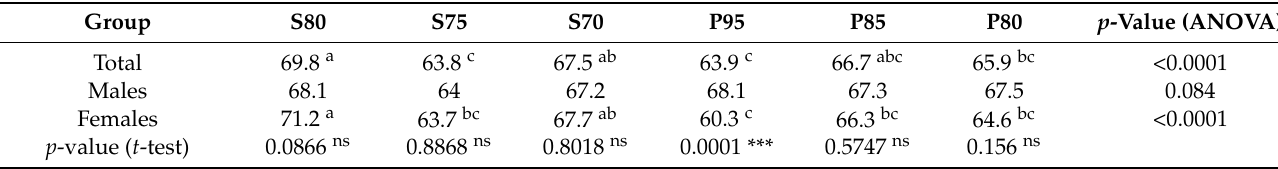
Table 2. Consumers’ overall liking mean values obtained from all subjects ( n = 358), males ( n = 163) and females ( n = 195) for six Gorgonzola cheese